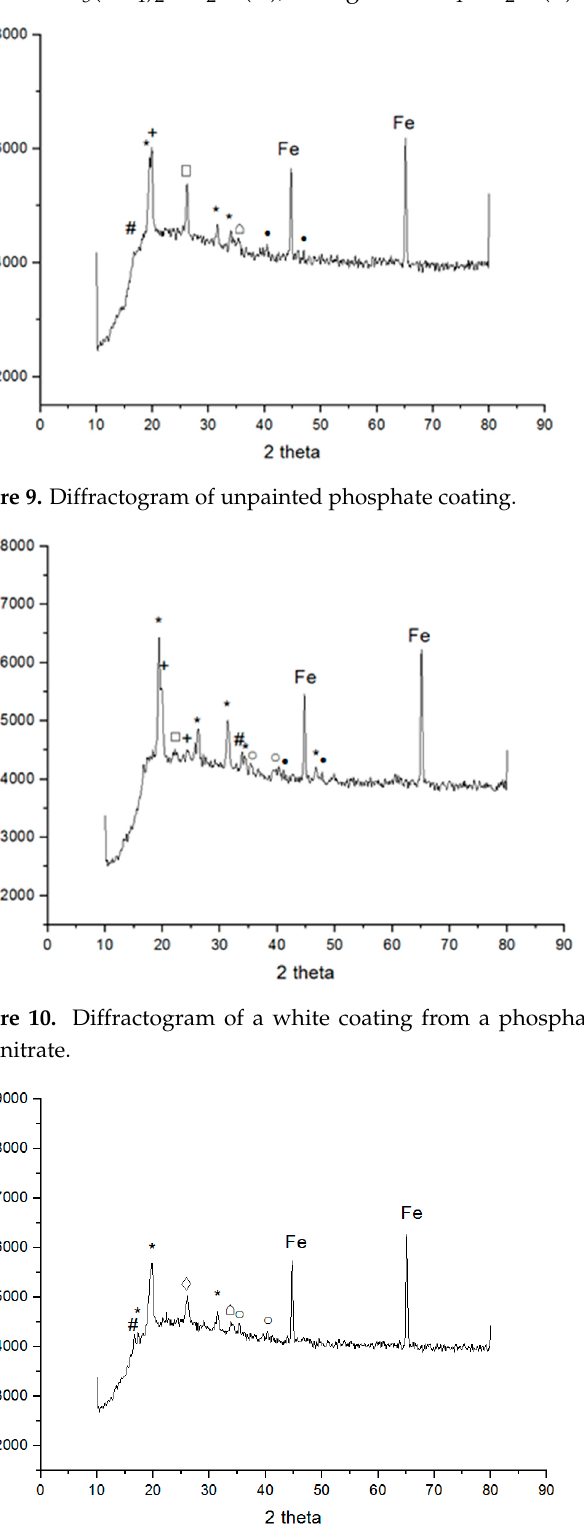
Figure 11. Diffractogram of a white coating from a phosphating solution with the addition of cal- cium nitrate.